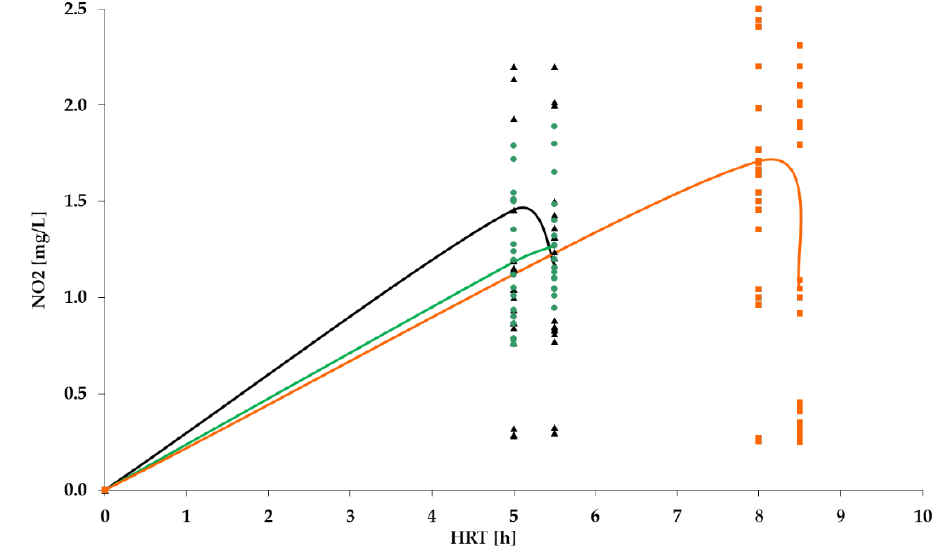
Figure 20. NO 2 : stage 1 (black); stage 2 (green); stage 3 (orange).